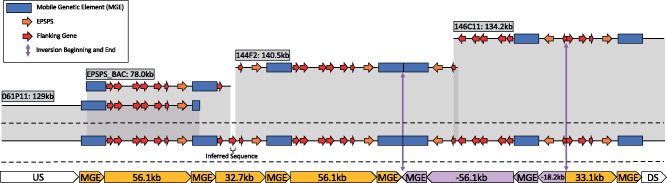
—A diagram of the four assembled BACs and how they overlap to generate five different repeat types of the EPSPS CNV locus from glyphosate-resistant kochia. The MGE is illustrated as a blue rectangle, the EPSPS gene is a green arrow, the coduplicated genes are orange arrows, and the beginning and end of the inverted repeat are vertical arrow lines.